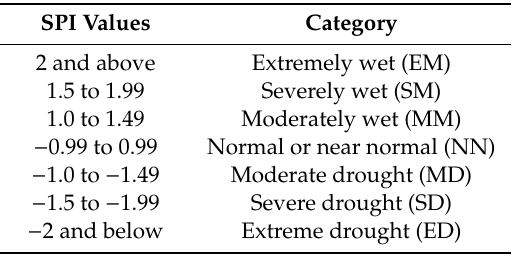
Table 2. Standardized precipitation index (SPI) values and categories.